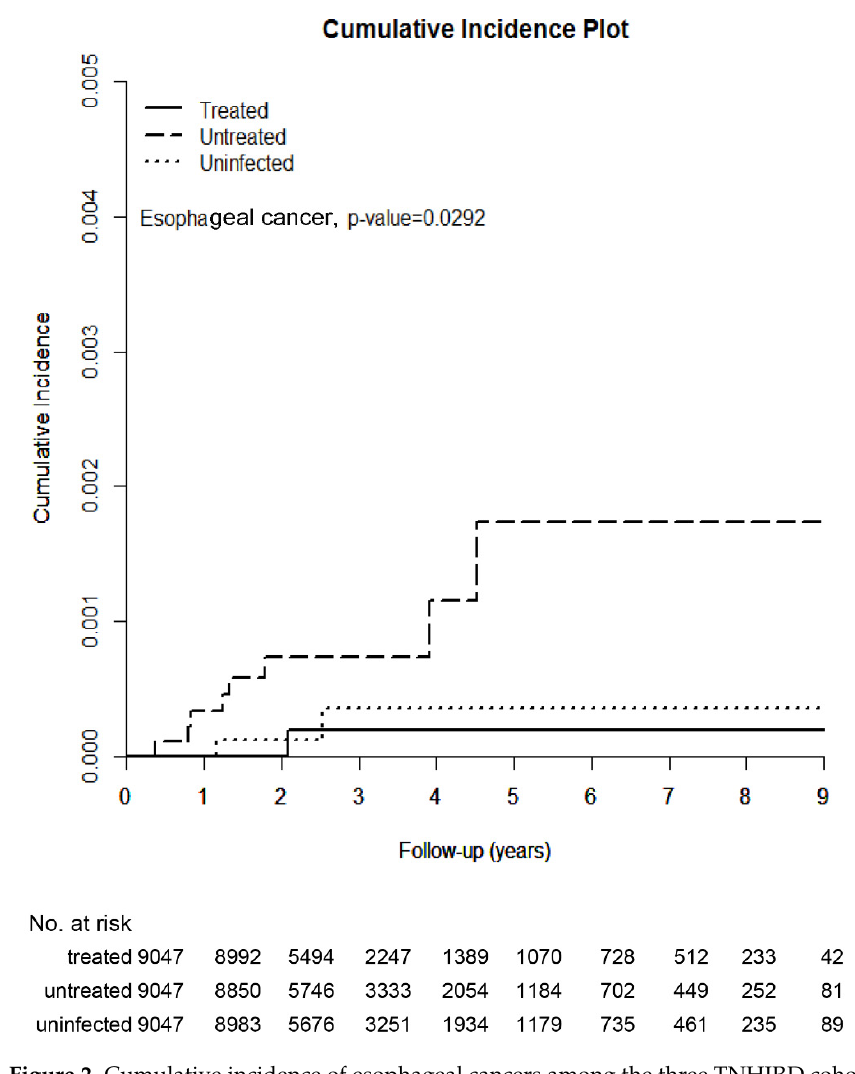
Figure 2. Cumulative incidence of esophageal cancers among the three TNHIRD cohorts, including HCV-treated, HCV-untreated, and HCV-uninfected cohorts. Table 2. Comparison of the cumulative incidences of esophageal cancers among (1) HCV-treated, (2) HCV-untreated, and (3) HCV-uninfected